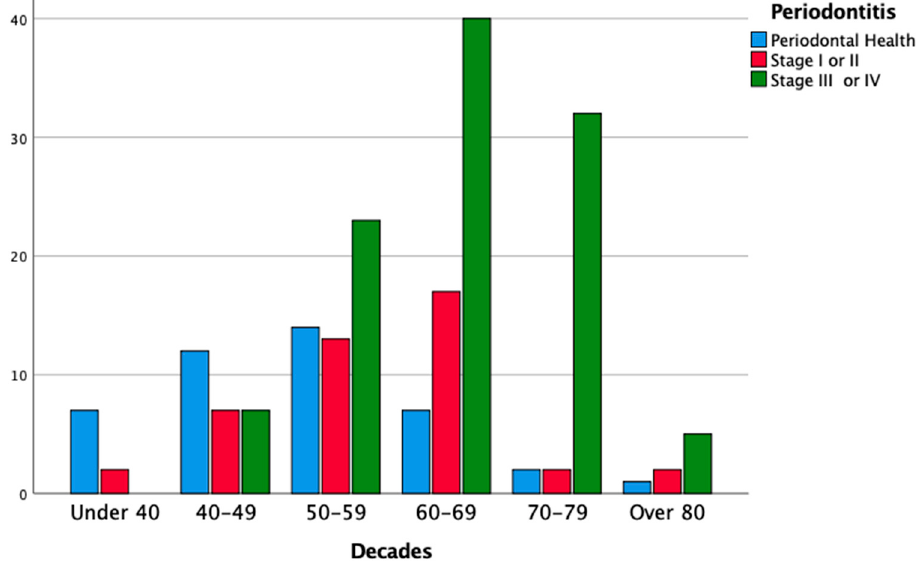
Figure 4. Distribution of periodontitis according to age of the patients (in decades). Table 5. General and oral health characteristics of the studied population, according to the age of the subjects